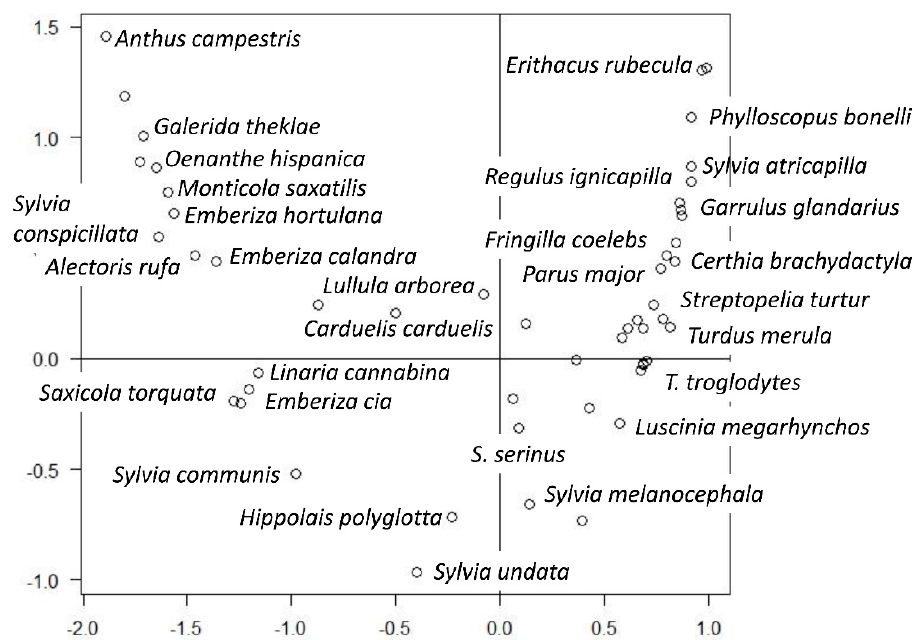
Figure 4. Ordination of bird species on the two first planes of the correspondence analysis, and the histogram of the eigenvalues. Only the names of the most contributing and/or common species are given. The corresponding scores of the bird species on the first axis (horizontal) are given on Table A1.